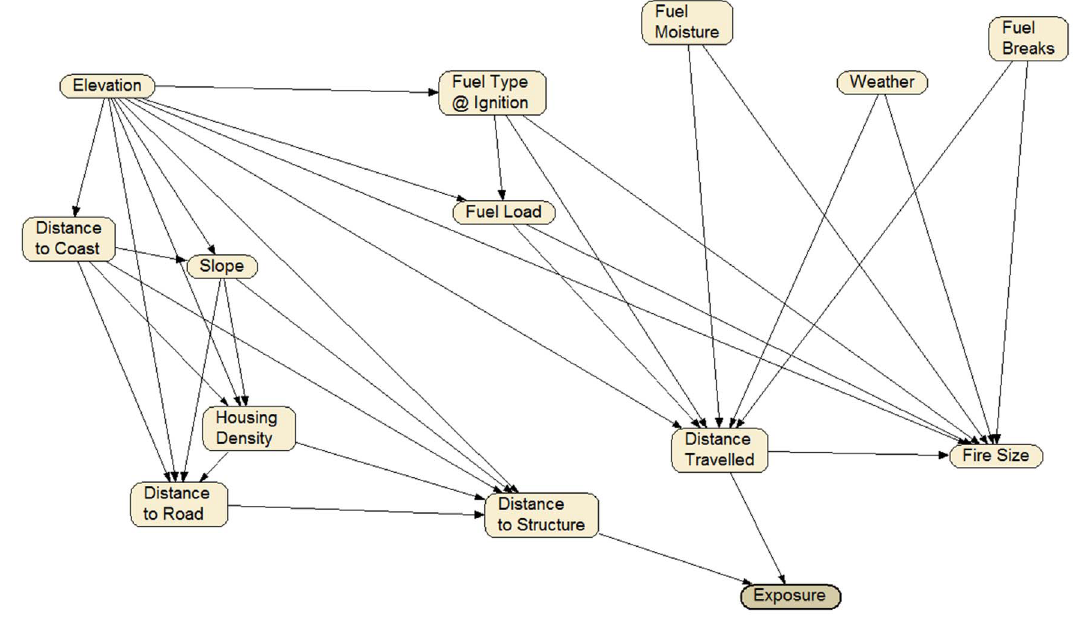
Figure 2. Influence diagrams for the Bayesian Network Model See Table 1 for node definitions and states.